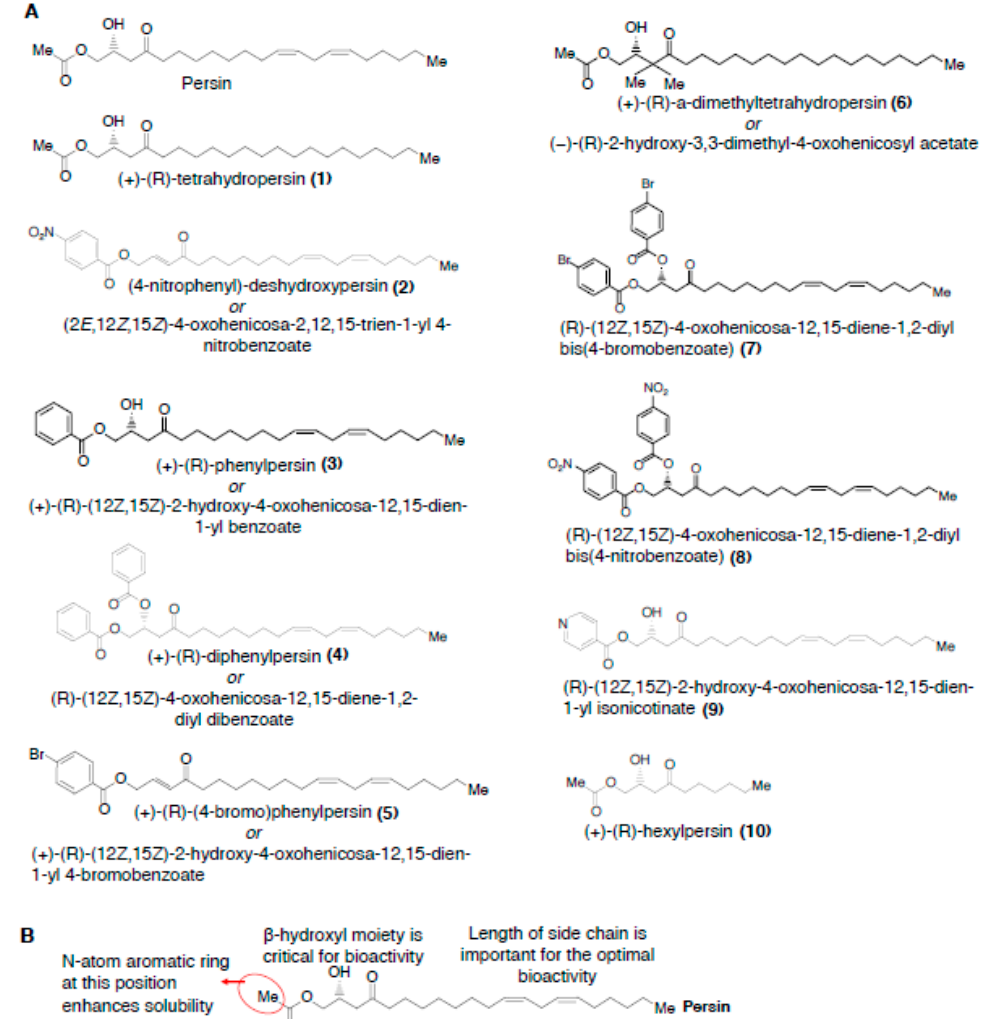
Figure 3. A ) Chemical structures of persin and persin analogues. B ) Structure-activity